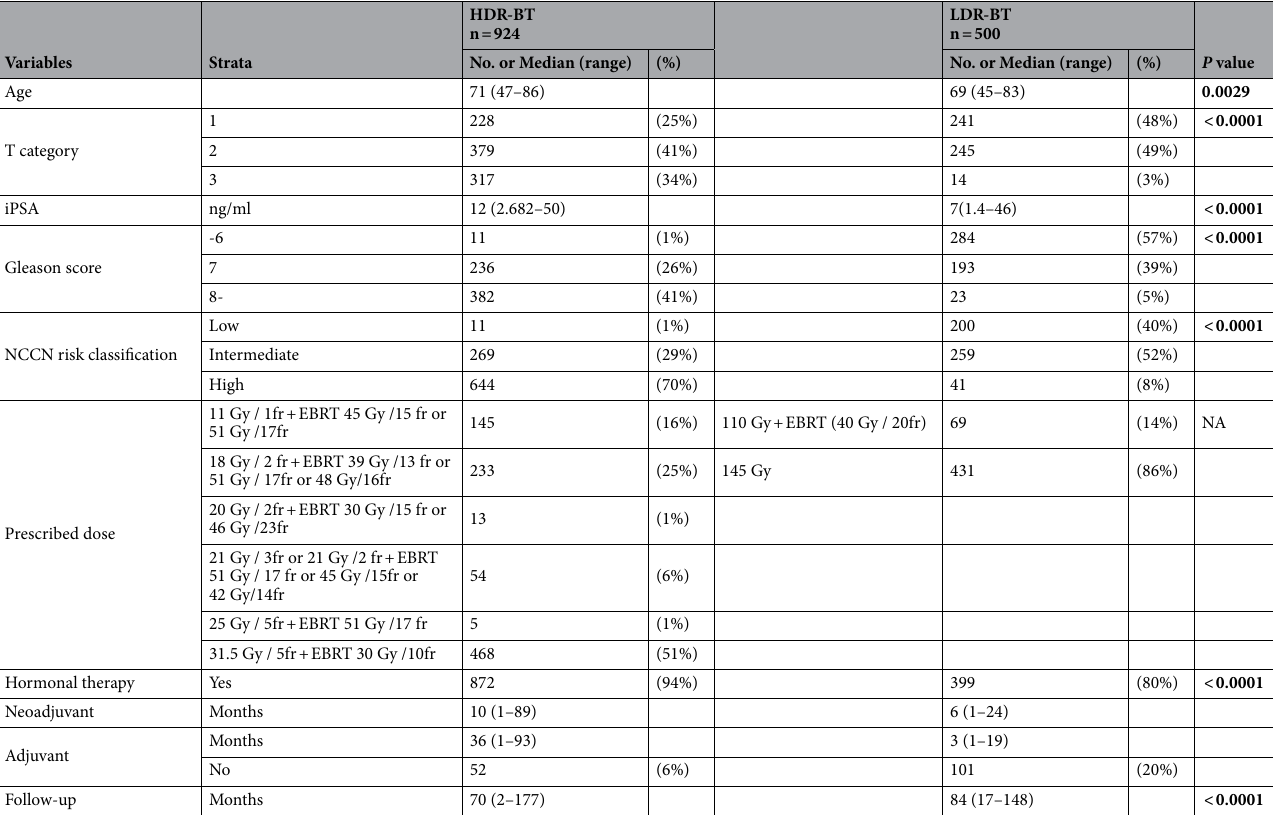
Table 1. Characteristics and treatment factors of patients. *Bold values indicate statistically significance, NA; not available. HDR‑BT high dose rate brachytherapy, LDR‑BT low-dose-rate brachytherapy, EBRT external beam radiotherapy (40 Gy/ 20